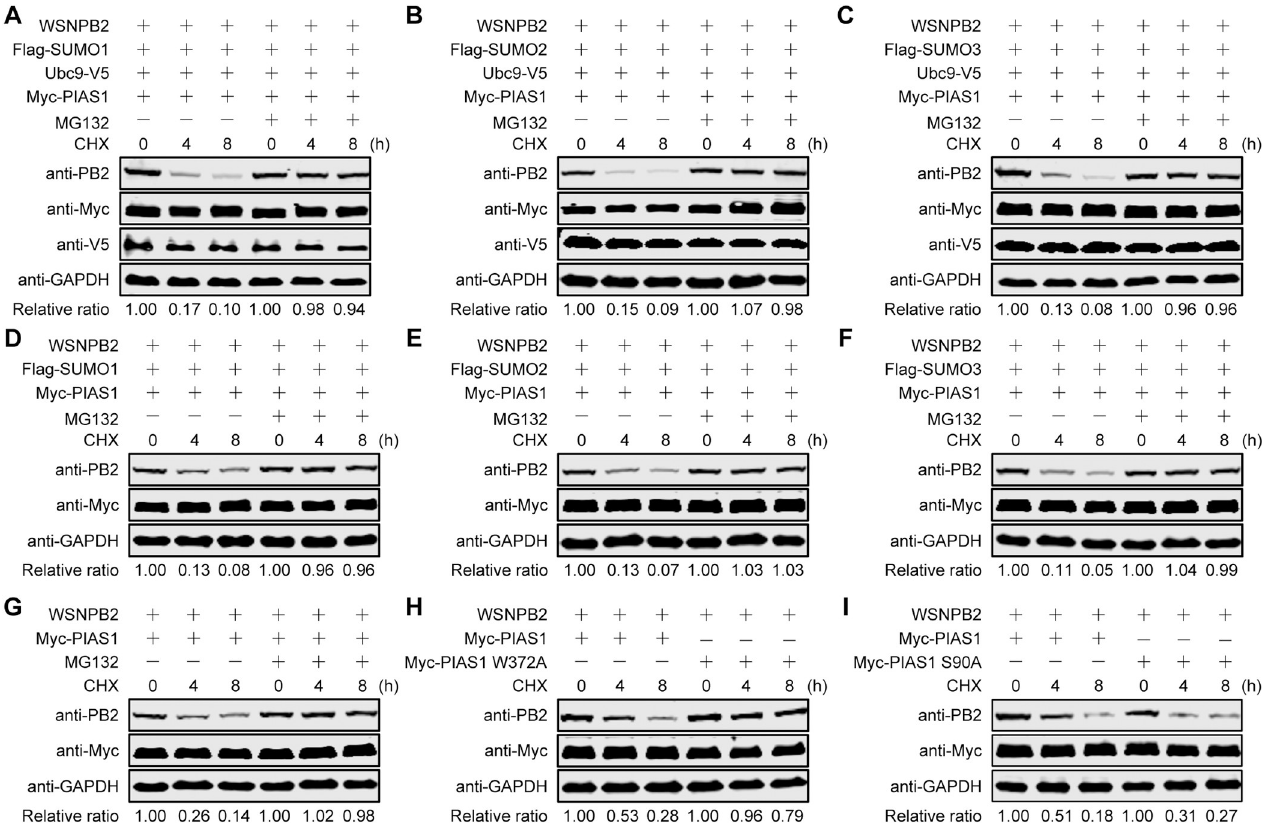
Fig 8. PIAS1-mediated SUMOylation leads to degradation of PB2 through the ubiquitin-proteasome pathway. (A-C) Stability of PB2 in cells overexpressing SUMO1/2/3, Ubc9, and PIAS1 in the presence or absence of MG132. HEK293T cells were transfected with plasmids for the expression of WSNPB2, Ubc9-V5, Myc-PIAS1, and Flag-SUMO1 (A), Flag-SUMO2 (B), or Flag-SUMO3 (C). At 36 h post-transfection, the cells were treated with CHX or with CHX and MG132. At the indicated timepoints, cell lysates were subjected to western blotting. (D-F) Stability of PB2 in cells overexpressing SUMO1/2/3 and PIAS1 in the presence or absence of MG132. HEK293T cells were transfected with plasmids for the expression of WSNPB2, Myc-PIAS1, and Flag-SUMO1 (D), Flag-SUMO2 (E), or Flag-SUMO3 (F). At 36 h post-transfection, the cells were treated with CHX or with CHX and MG132. At the indicated timepoints, cell lysates were subjected to western blotting. (G) Stability of PB2 in cells overexpressing PIAS1 in the presence or absence of MG132. HEK293T cells were transfected with plasmids for the expression of WSNPB2 and Myc-PIAS1. At 36 h post-transfection, the cells were treated with CHX or with CHX and MG132. At the indicated timepoints, cell lysates were subjected to western blotting. (H, I) Effect of the PIAS1 mutant on the stability of PB2. HEK293T cells were transfected with plasmids for the expression of WSNPB2, Myc-PIAS1, and Myc-PIAS1 W372A (H) or Myc-PIAS1 S90A (I). At 36 h post-transfection, the cells were treated with CHX. At the indicated timepoints, cell lysates were subjected to western blotting. Data are representative of three independent experiments (A-I). The band intensities of PB2, quantified by using ImageJ software, were normalized to GAPDH and are expressed as relative ratios compared with untreated cells at 0 h at the bottom of each